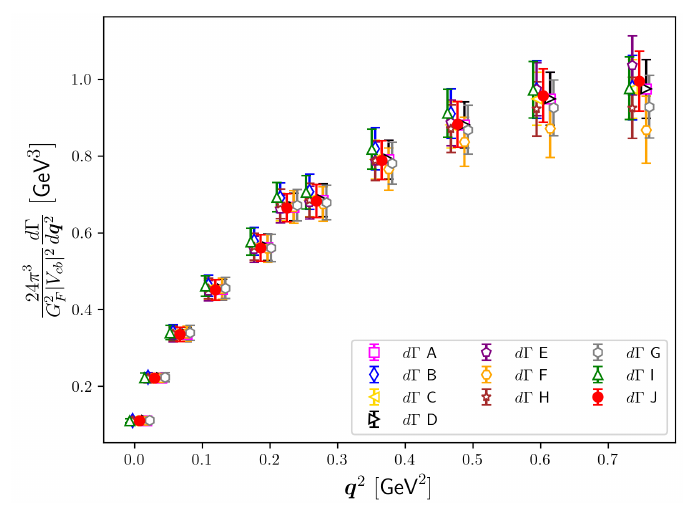
d Γ , obtained changing the parameters given as input to our d q 2 G 2 | V cb | 2 F